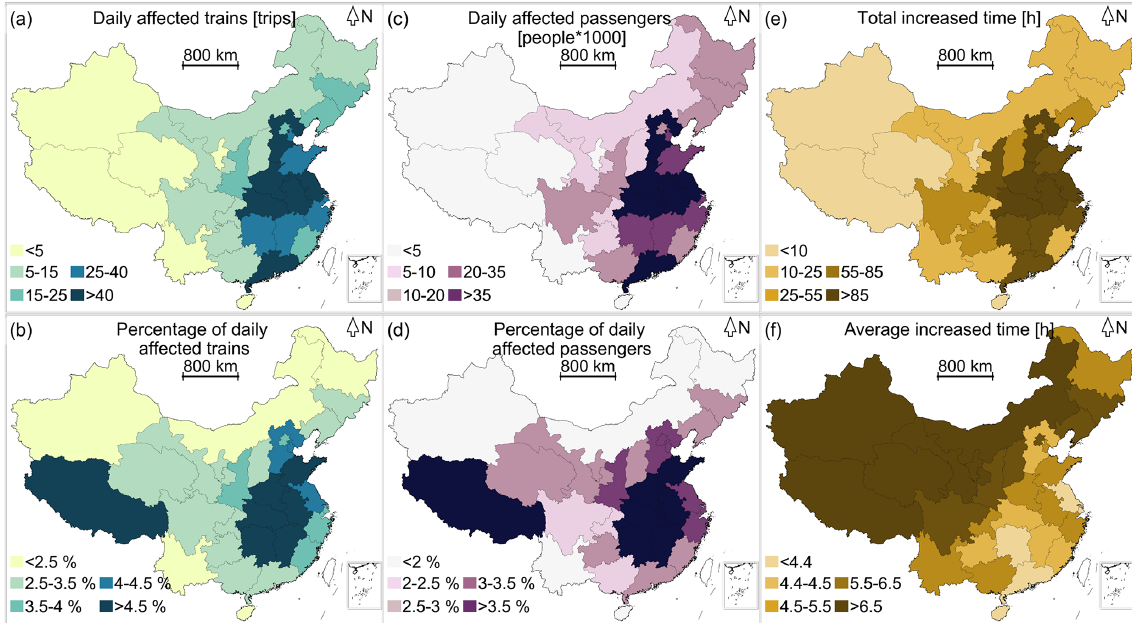
Figure 6. Performance loss of the railway system per province. (a) The daily affected trains in absolute terms, (b) the daily affected trains relative to the number of the province’s daily trains, (c) the daily affected passengers in absolute terms, (d) the daily affected passengers relative to the number of the province’s daily passengers, (e) the daily total increased time for the detoured trains per province, and (f) daily average increased time for the detoured trains per province. Appendix Fig. A4 provides the risk map of detoured and cancelled trains and passengers influenced by detoured, cancelled trains. Appendix Fig. A5 provides a map of the Chinese